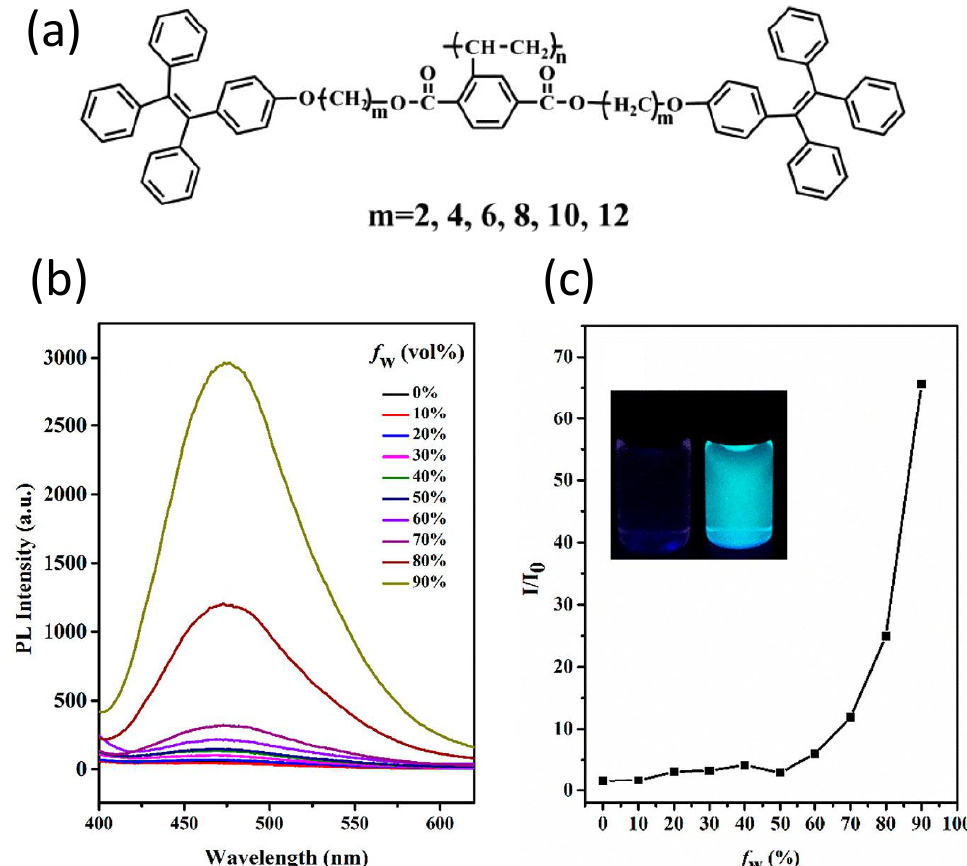
Figure 18. ( a ) Molecular structures of the LCPs. ( b ) Emission spectra of the polymer (shown above, m = 6) in THF/H 2 O mixtures with various water fractions. ( c ) Plots of I/I 0 values versus water contents of the aqueous mixtures at 476 nm for the polymer (show above, m = 6); the inset photos of THF with 0 and 90% water fractions taken under UV light. Reproduced with permission from reference [140]. Copyright 2017, American Chemical Society.